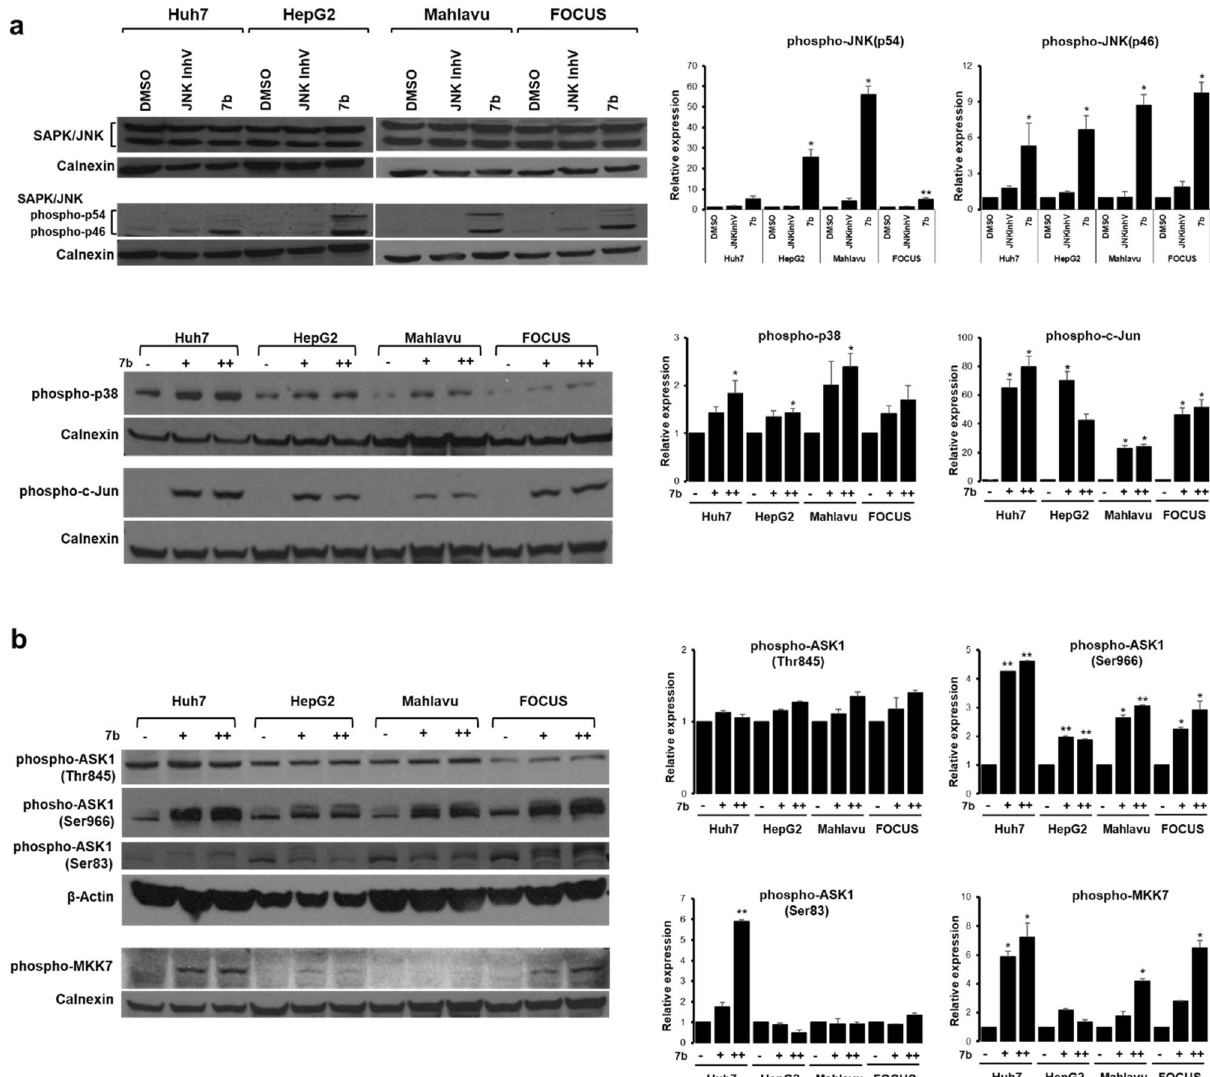
Figure 5. 7b activates the JNK pathway in HCC cell lines. ( a ) Representative western blot images of total or active (phosphorylated) JNK1 and JNK2 protein levels in HCC cell lines treated with increasing concentrations of compound 7b , cell line-specific IC 50 concentrations of JNKInhV (Huh7: 2 μM, HepG2: 2 μM, Mahlavu: 5 μM, FOCUS: 0.5 μM), and DMSO control (top left panel); phospho-p38 and phospho-c-Jun levels in HCC cell lines treated with increasing concentrations of 7b (+ : IC 50 , + + : 2 × IC 50 ) and DMSO control (bottom left) for 24 h. Bar graphs represent quantitative analysis of the relative band intensity values obtained from 3 different experiments of each treatment group for phosphorylated JNK, phosphorylated c-Jun proteins compared to DMSO using the ImageJ analysis tool (right panel). ( b ) Representative images indicate the changes in the levels of P-MKK7, P-ASK1 Thr845 , P-ASK1 Ser966 and P-ASK1 Ser83 proteins by western blot analysis. Huh7, HepG2, Mahlavu, and FOCUS cells were treated with increasing concentrations of compound 7b and corresponding DMSO for 24 h (bottom left panel). Bar graphs represent quantitative analysis of the relative band intensity values obtained from 3 different experiments of each treatment group for MKK-7, and phosphorylated ASK1 proteins compared to DMSO using ImageJ analysis tool (right panel). Calnexin or β-actin were used as equal loading controls for all western blot